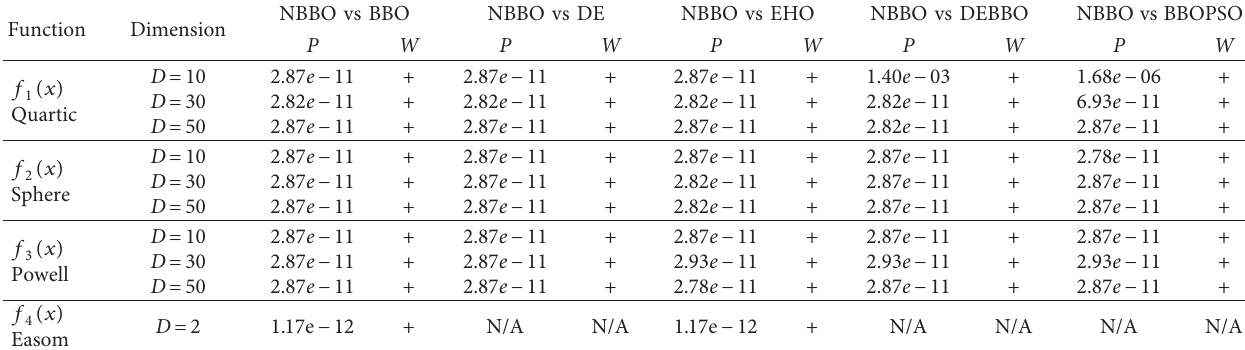
: Griewank ( d � 30 ) , (f) f 6 : Kowalik ( d � 4 ) . 8 Table 5: Wilcoxon rank sum test results of unimodal function.